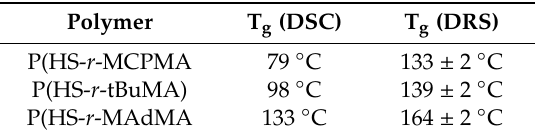
Table 1. Di ff erential scanning calorimetry (DSC) (bulk) and DRS (30 nm thin film) measurement results for T g for di ff erent